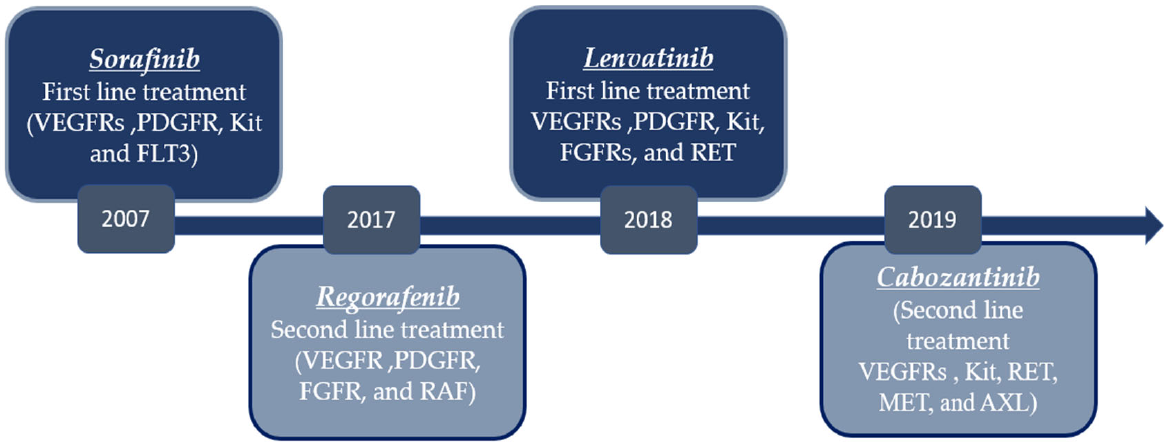
Figure 3. The chronological sequence of the currently FDA approved small molecule inhibitors in HCC and their primary molecular targets Interferon ‐ Lambda 3